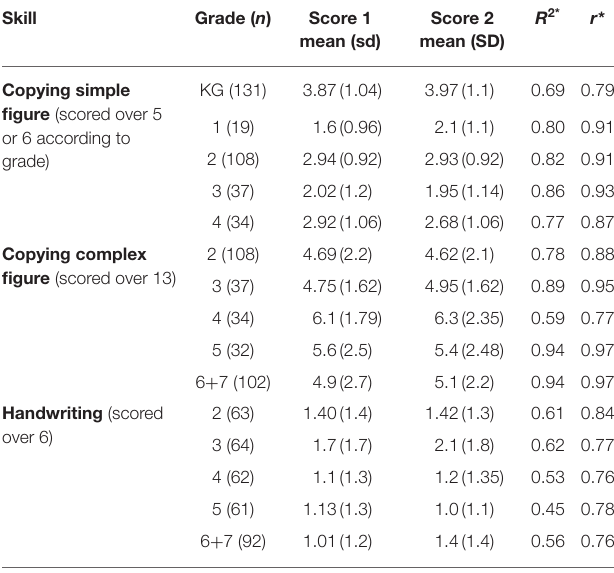
TABLE 3 | Inter-rater reliability coefficients for drawing and handwriting scores. Skill Grade ( n )